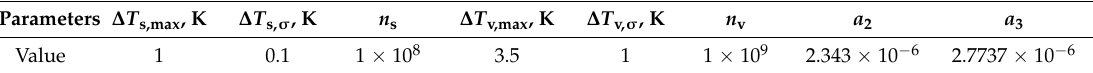
Table 3. Nucleation parameters of CAFE (Cellular Automaton-Finite Element)